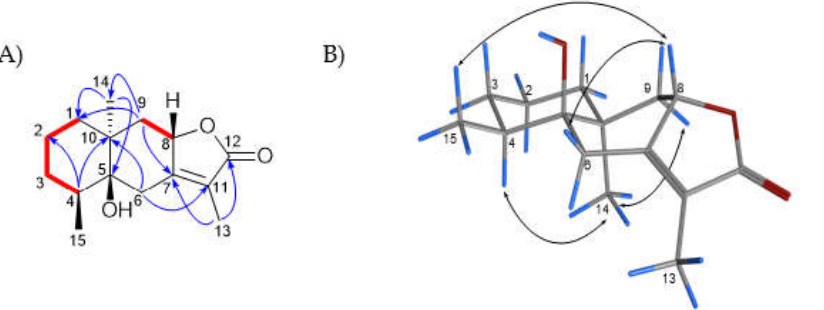
Figure 3. ( A ): Key COSY (red bold bonds) and HMBC (blue arrows) correlations ( B ): NOESY (double headed arrows) correlations observed for compound 3.